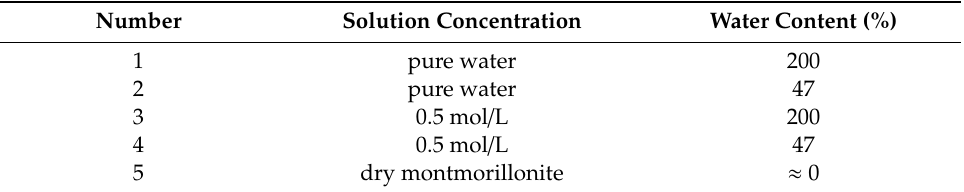
Table 2. Montmorillonite samples for crystal characterization experiments.